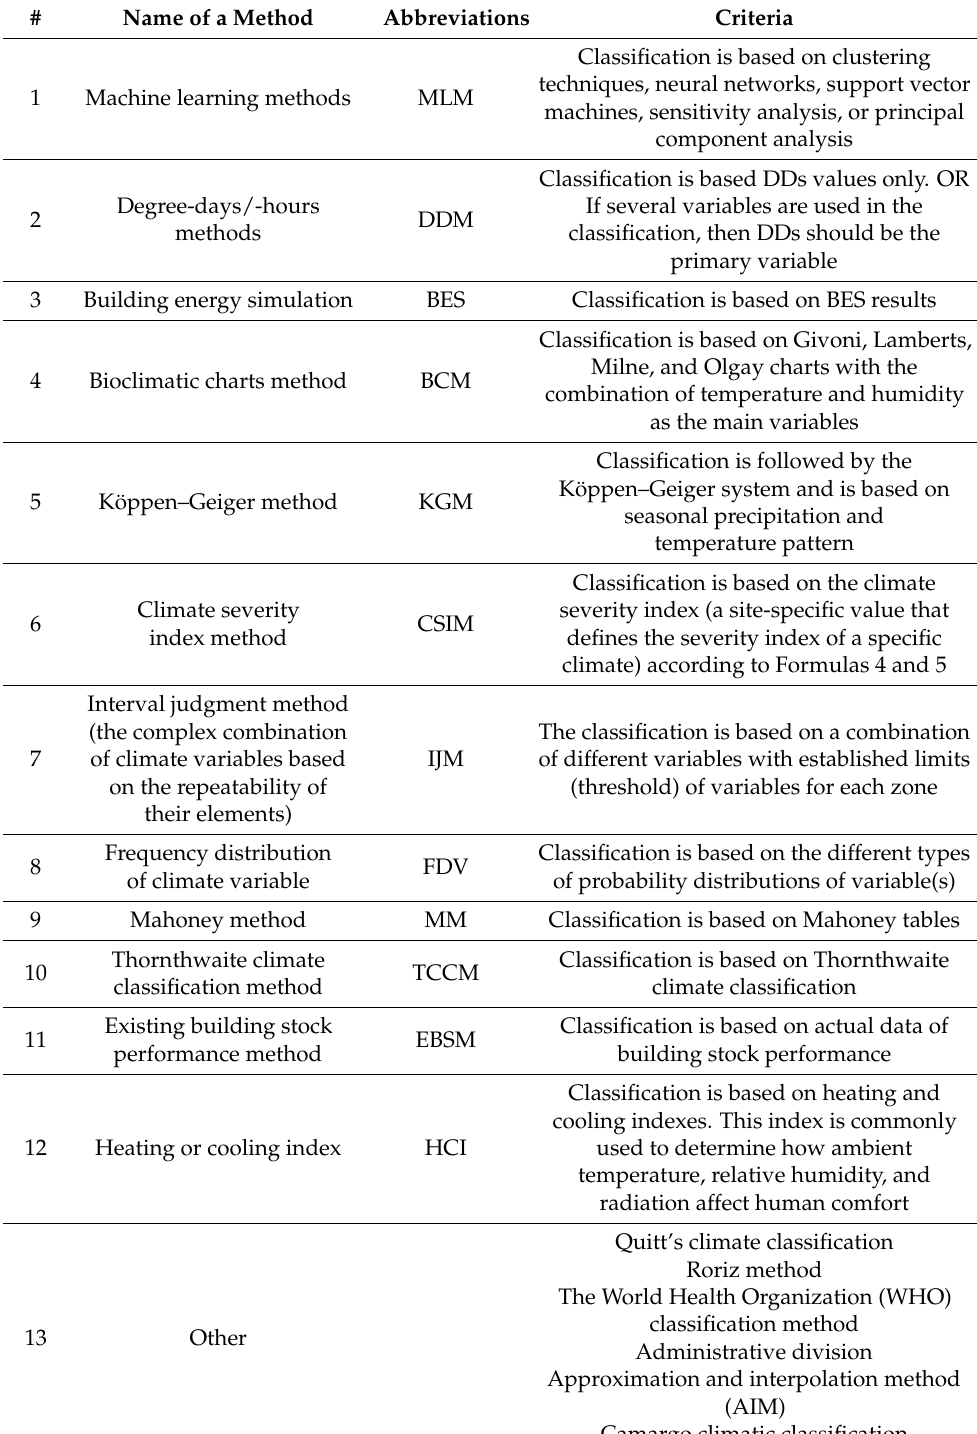
Table 3. CZ methods